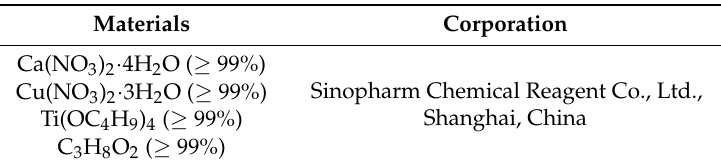
Table 1. List of drugs for this experiment.